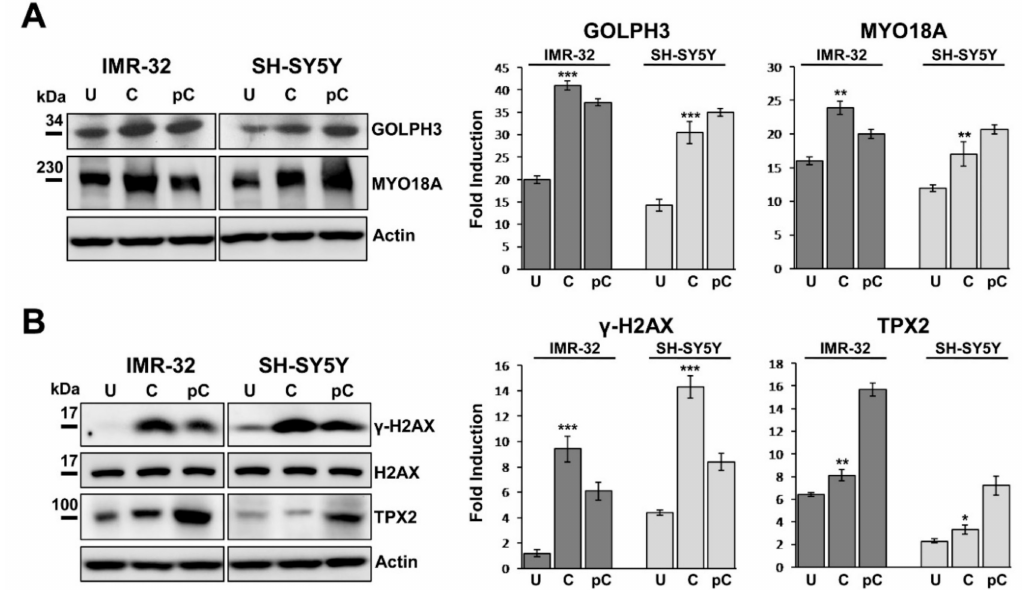
Figure 4. Curcumin treatment induces MYO18A up-regulation and TPX2 activation in neuroblastoma cells. ( A ) Protein lysates from IMR-32 and SH-SY5Y cells cultured in 10 or 20 µ M curcumin respectively for 48 h (C = curcumin) and lysates from the same cells collected 48 h after curcumin depletion (pC = post-curcumin), were subjected to Western blot analysis with anti-GOLPH3 and anti-MYO18A antibodies. ( B ) The same lysates were subjected to Western blot analysis with anti- γ H2AX and anti-TPX2 antibody. Untreated cells (U) were cultured with 0.1% DMSO. Protein levels were quantified by densitometry, normalized to the content of the loading control protein (total H2AX or actin) and visualized by histograms. Data are representative of three independent experiments ± SD. (* p < 0.05; ** p < 0.01; *** p <